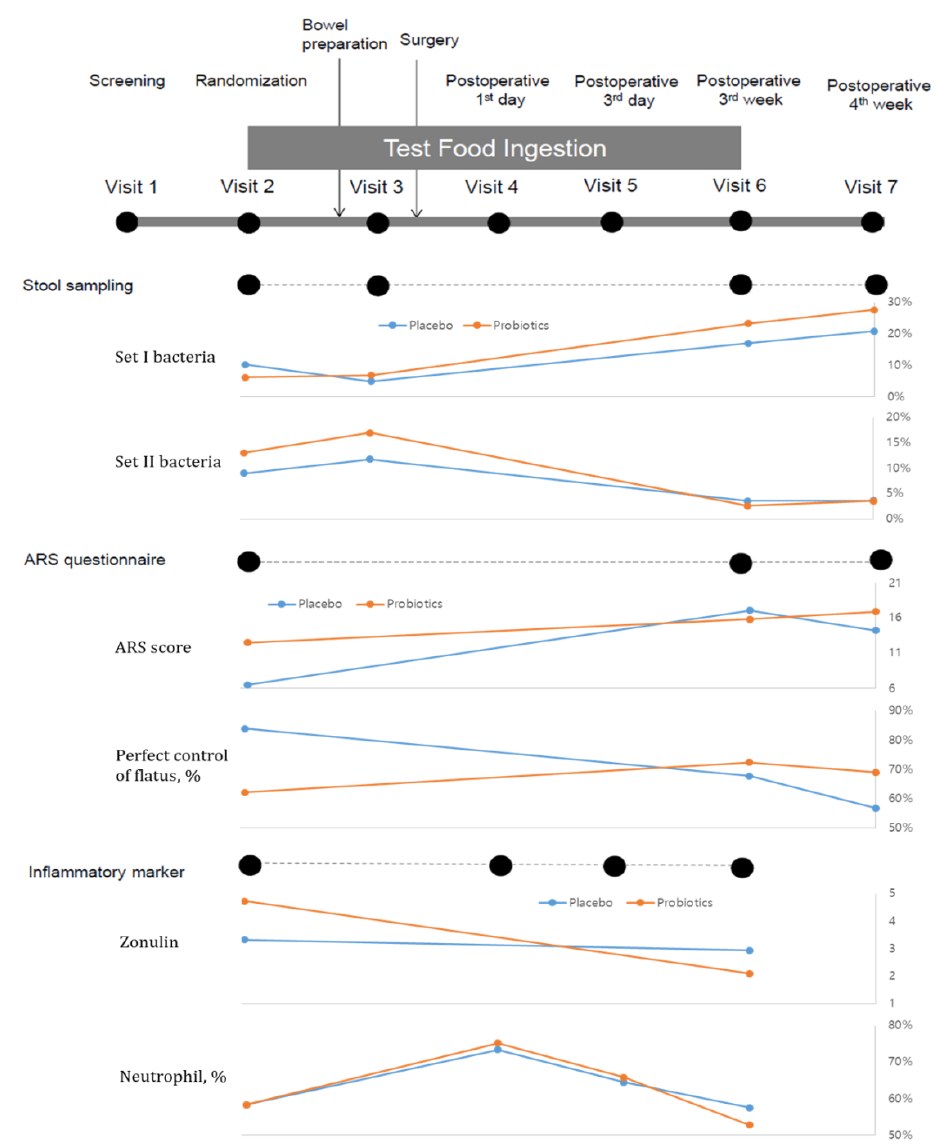
Figure 2. Clinical and laboratory analysis and fecal sampling schedule during the study period. ARS, anterior resection syndrome.